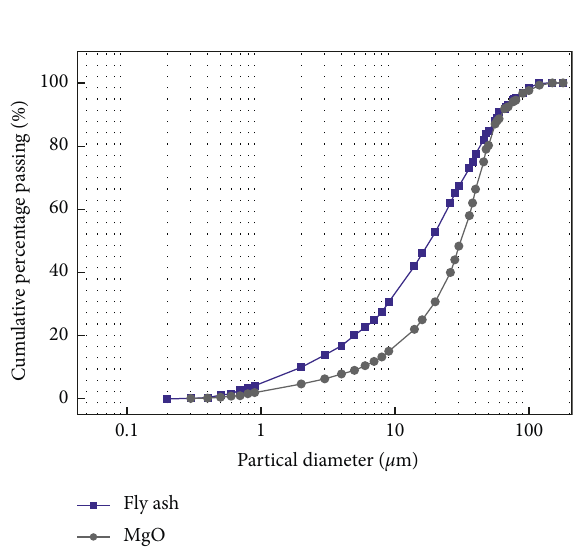
Figure 1: Particle size distribution of Figure 1. MgCl2 was produced by Qinghai Golmud. The content of magnesium chloride was more than 45%.